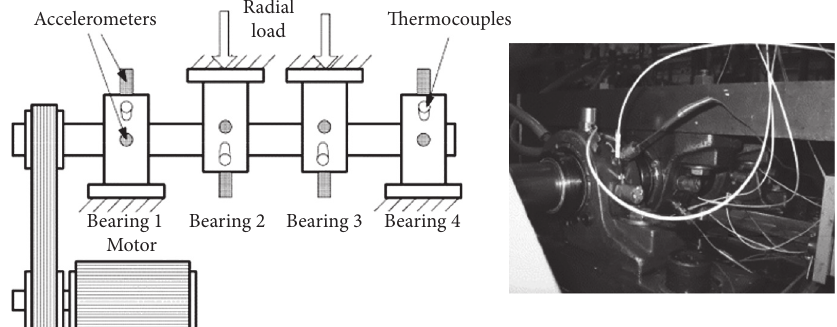
Figure 6: Test rig for accelerated degradation of rolling bearing.